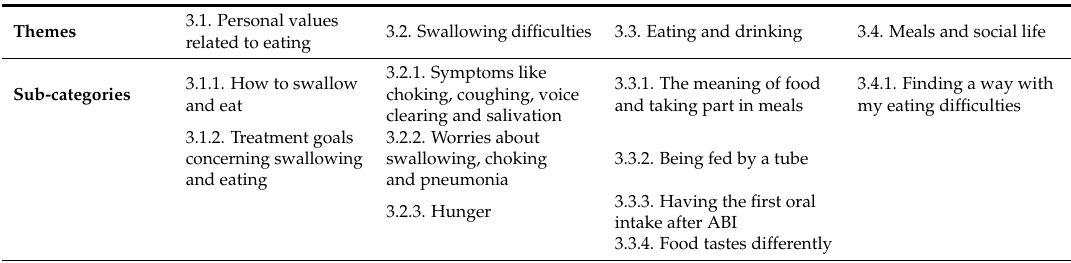
Table 4. An overview of the themes and